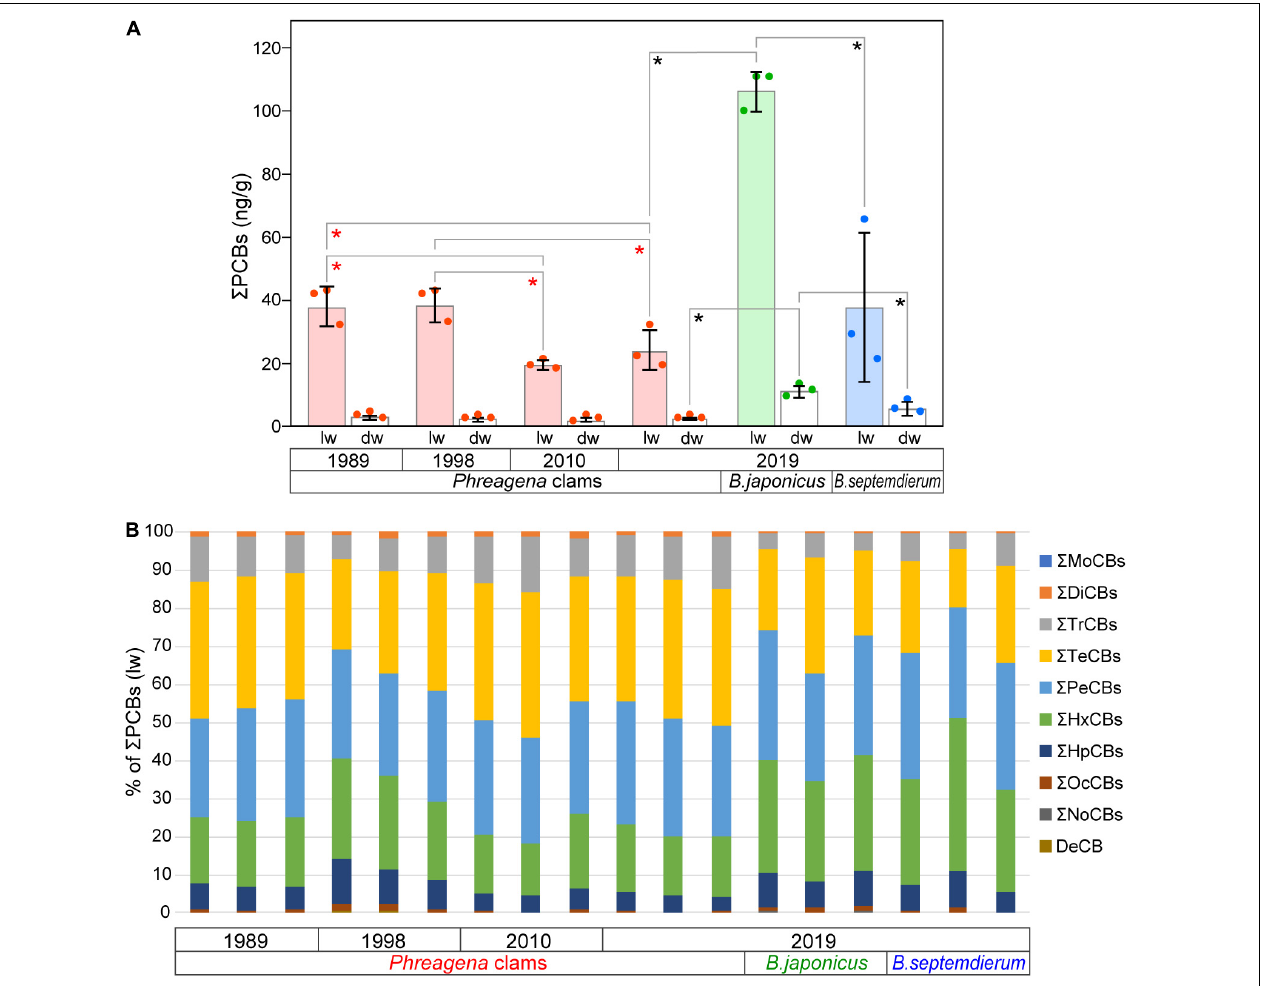
FIGURE 2 | PCB concentrations measured in the samples. (A) Mean total PCB concentrations per g lw and dw. The mean values from three individuals are shown for each bivalve species and each collection year. Pink, light green, and light blue bars indicate mean total PCB concentrations per g lw for Phreagena clams, Bathymodiolus japonicus , and Bathymodiolus septemdierum , respectively. White bars are mean values per g dw. Red, green, and blue dots indicate the values for Phreagena clams, B. japonicus , and B. septemdierum , respectively. Red and black asterisks indicate statistically significant differences ( P < 0.05) in the Phreagena clam samples and in the bivalves collected in 2019, respectively. Error bars represent the standard deviation ( n = 3). (B) Congener compositions of PCBs in all samples. Concentrations are based on the weight per lipid. Mo, mono-; Di, di-; Tr, Tri-; Te, tetra-; Pe, penta-; Hx, hexa-; Hp, hepta-; Oc, octa-; No, nona-; De, deca-; PCB, polychlorinated biphenyl; lw, lipid weight; dw, dry